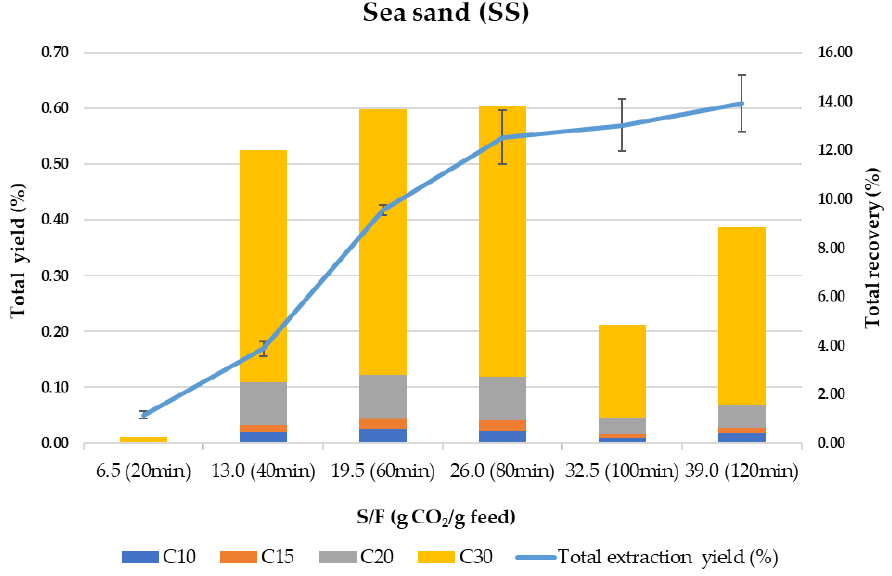
Figure 2. Total extraction yield (%) and total terpenes recovery (%) using sea sand (SS) as adsor-